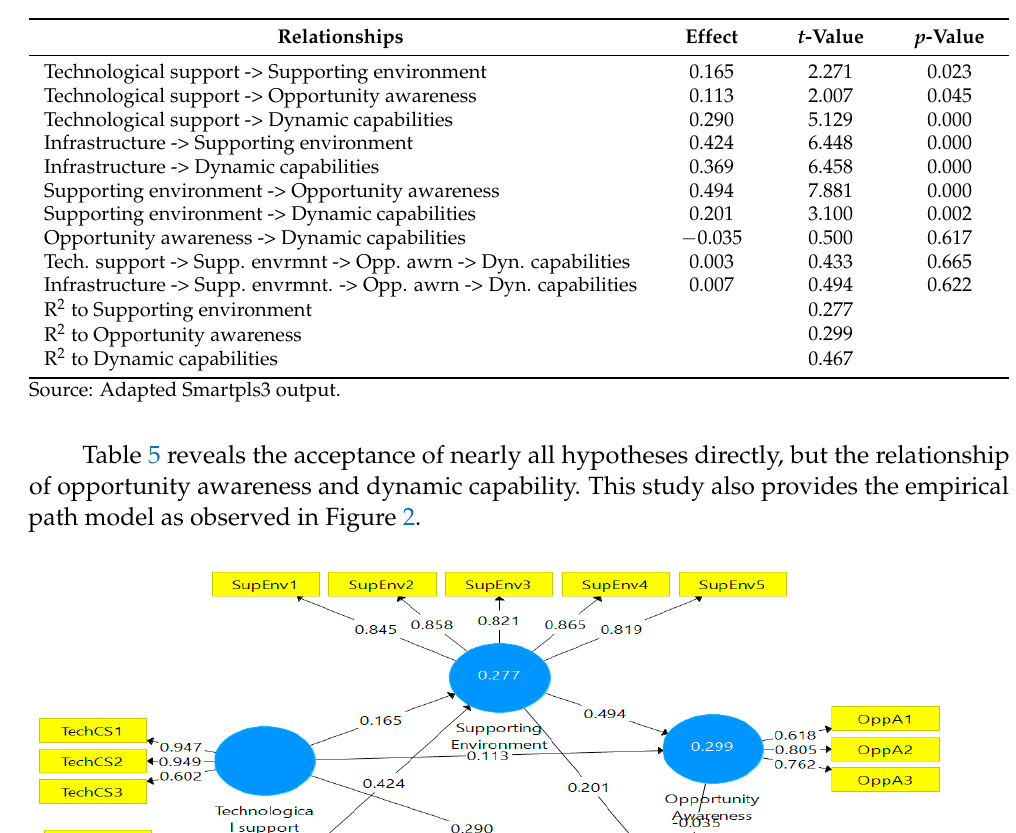
Table 5. The Summary of significance and relevance tests.